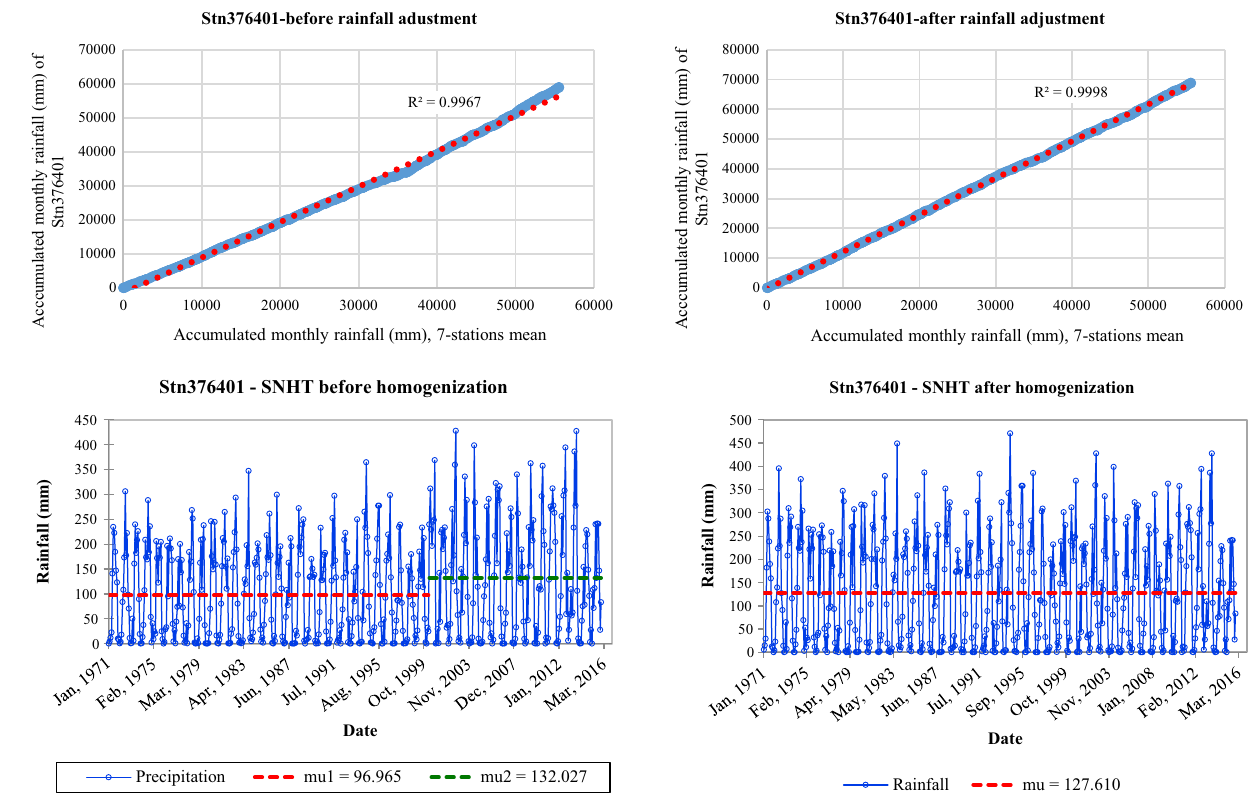
Fig. 4 Double mass curve plots and SNHT results for the Stn376401 before and after homogenization of the rainfall series during 1971–2015 Table 9 The p values obtained from the homogeneity tests for the monthly rainfall series during 1971–2015 for the Stn376401 after rainfall adjustment